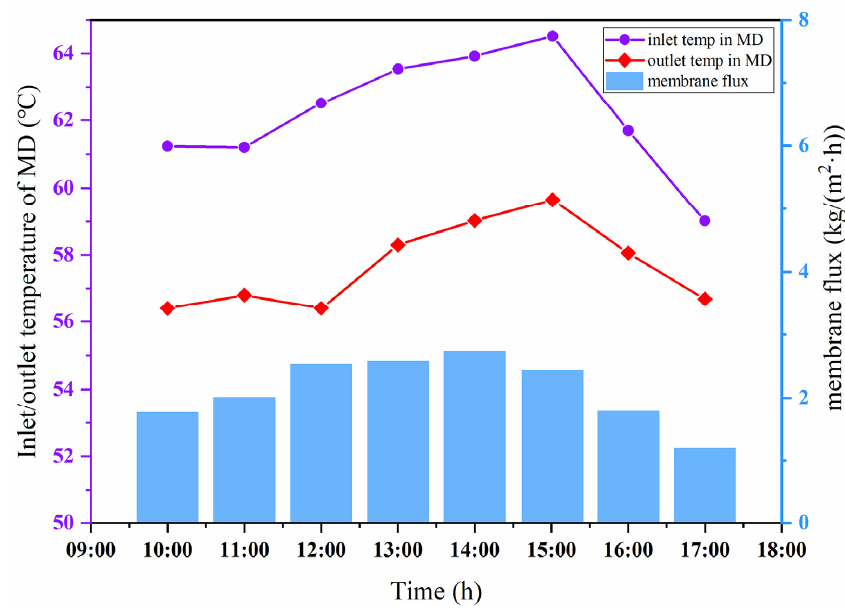
Figure 5. Variation trend of average inlet/outlet temperature and MF of VMD.